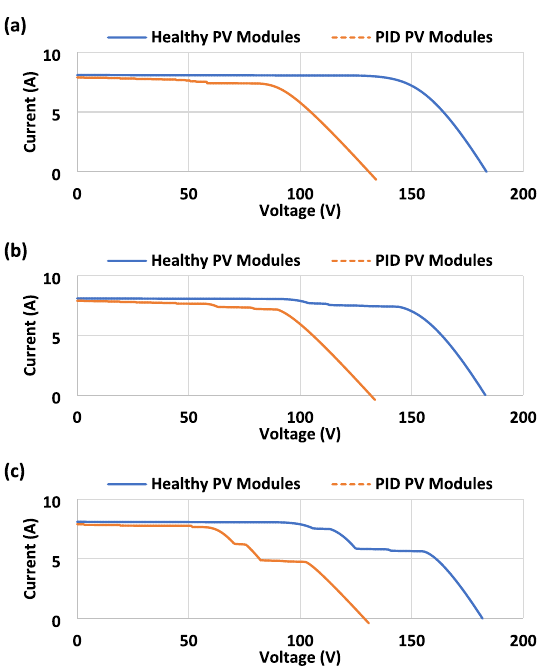
Figure 5. Current–Voltage (I–V) curve measurements of the examined PV modules. ( a ) Clear sky. ( b ) Partial shading. ( c ) Overcasting. The I-V curve tracking accuracy is ± 0.5%. The blue curves show the healthy PV modules (free PID), and the orange curves show the PID PV